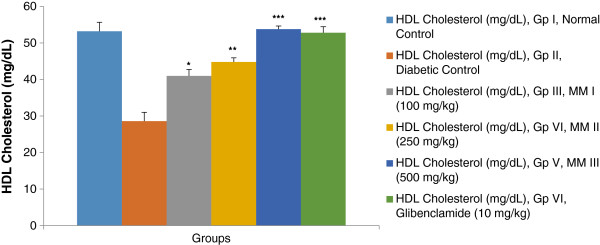
Effect of Melastoma malabathricum Linn. (MM) on level of HDL cholesterol at different concentrations on STZ induced diabetic rats, compared to standard drug Glibenclamide; values are mean ± SEM; n = 6; *P < 0.05; **P < 0.01; ***P < 0.001; P > 0.05 is considered as non-significant (ns).